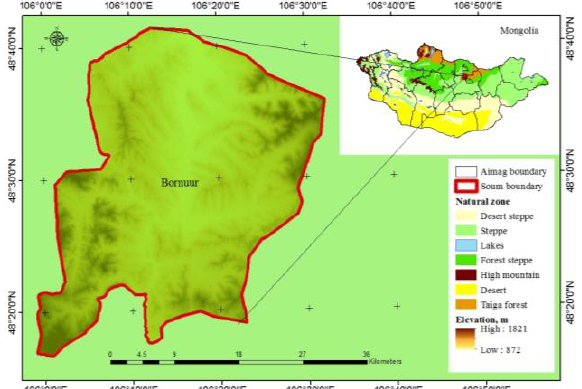
Figure 1. Study area (Bornuur soum in Tuv province in Mongolia)